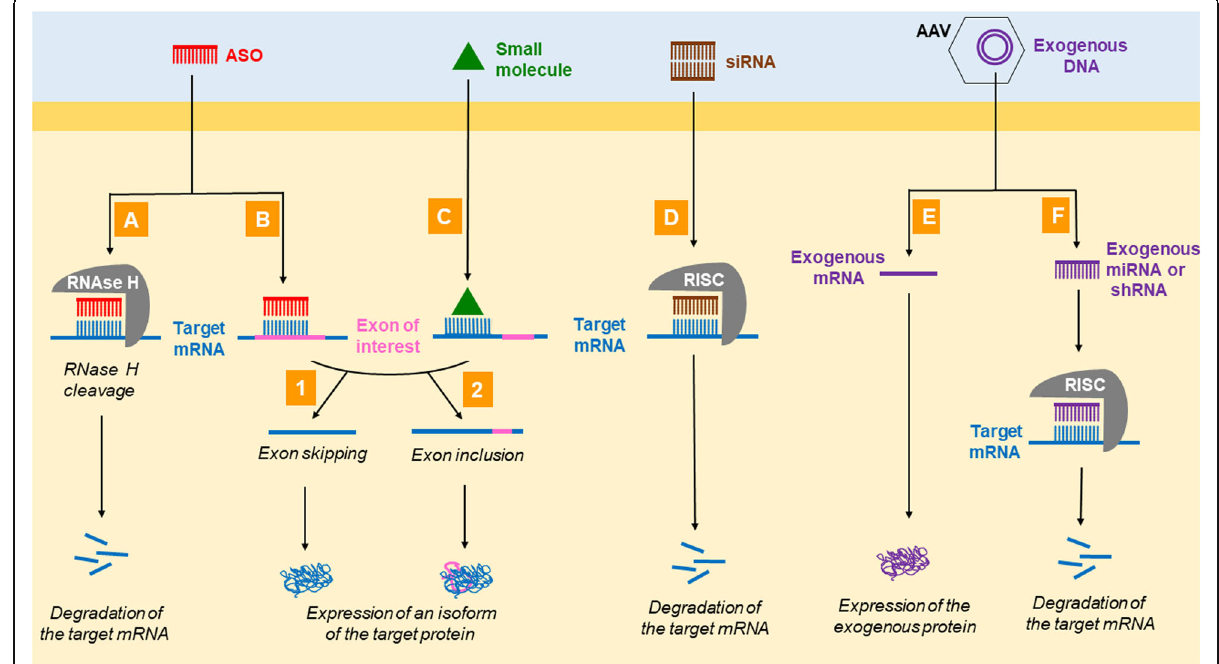
Fig. 1 Mechanisms of gene-specific therapies against neurological diseases used in clinical practise and tested in clinical trials. Gene-specific therapy with ASOs (A, B), small molecules (C), siRNA (D) or viral gene transfer (E, F). (A) Binding of the ASO to the target mRNA leads to RNase H-mediated degradation of the target mRNA. (B) ASO targeting the splice site of a specific exon to mediate exon skipping (1) or exon inclusion (2). Consequently, an isoform of the target protein is expressed. (C) Small molecule targeting the splice site of the exon to mediate exon skipping (1) or exon inclusion (2). Accordingly, an isoform of the target protein is expressed. (D) The target mRNA is degraded after binding to the complementary siRNA that is part of the RISC complex. (E) Viral delivery of exogenous DNA, which codes for the mRNA of choice (gene reconstitution). (F) Virally introduced exogenous DNA, which encodes a miRNA or shRNA that mediates the degradation of the target